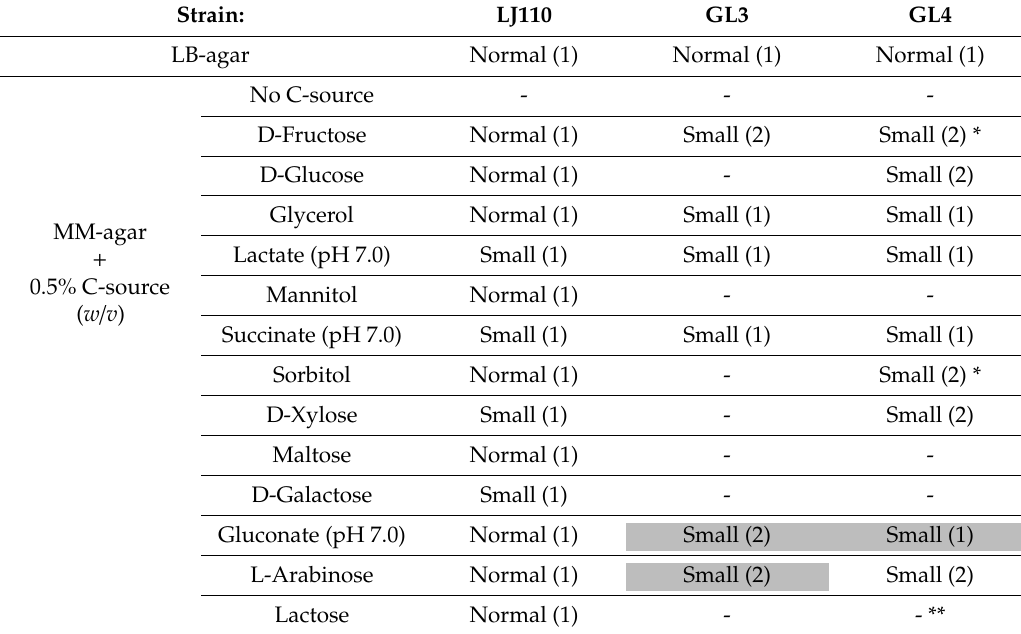
Table 2. Growth phenotypes of wild type LJ110 and mutant strains GL3 and GL4 on agar plates. LB-agar; minimal medium (MM)-agar [50] with 0.5% C-source ( w / v ). normal = single colonies with